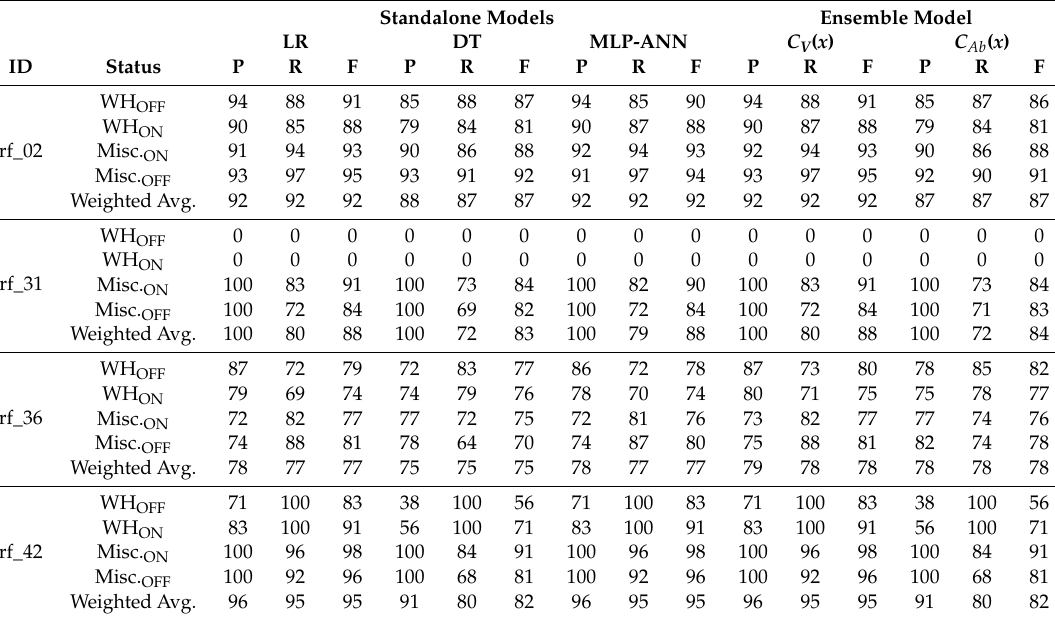
Table 7. Circuit-level inference results (in